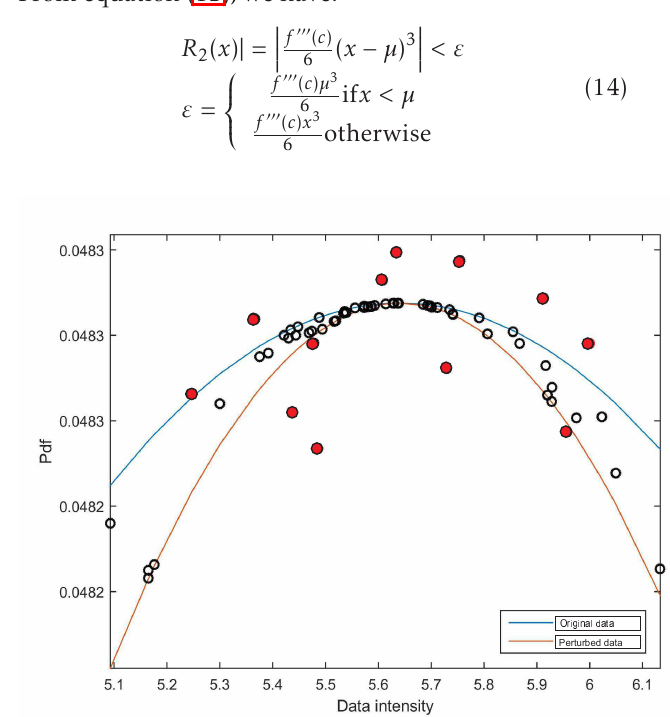
Figure 6. Watermark vulnerable